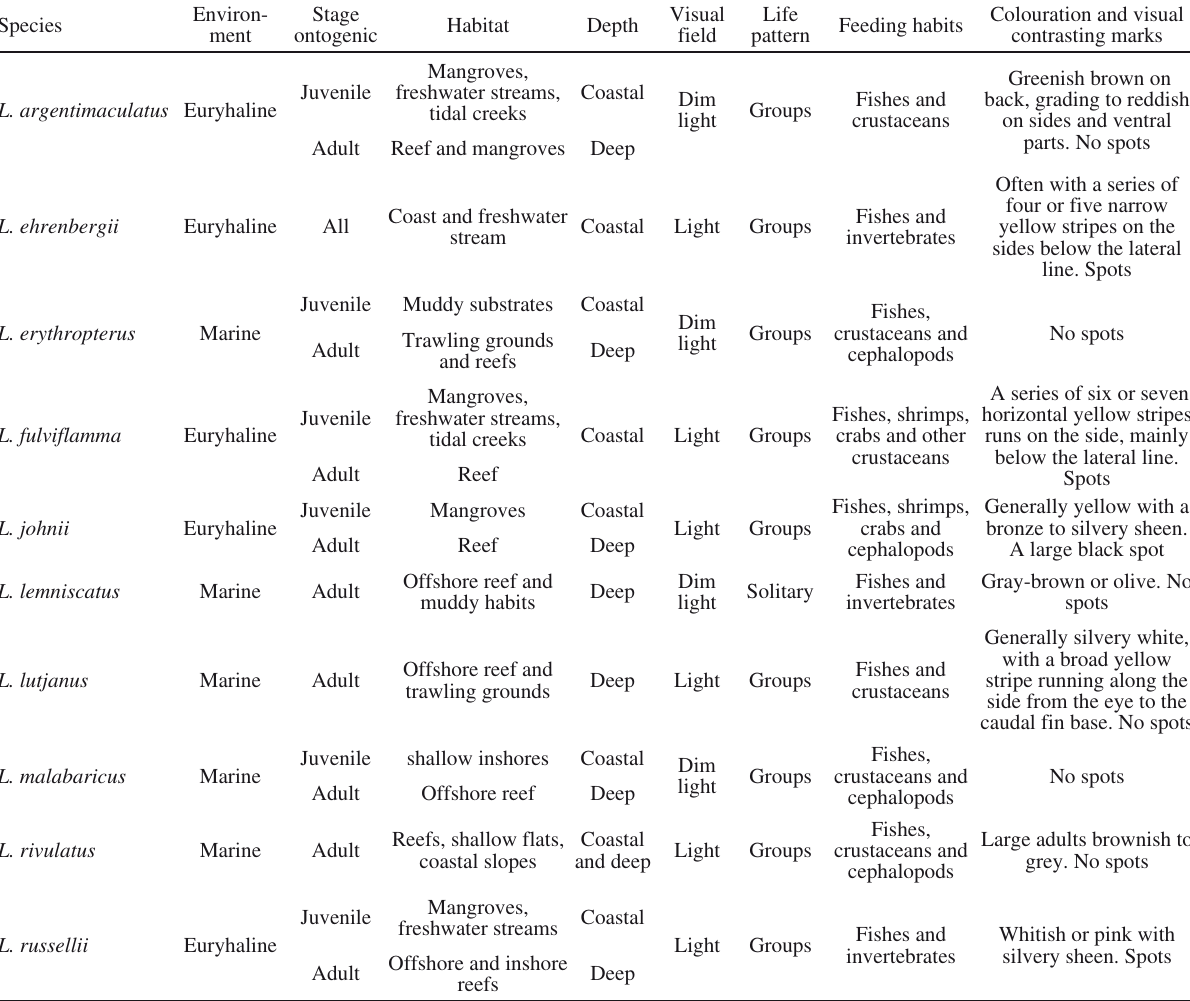
Table 2. − Summary of ecological, functional, morphological and feeding characteristics of snappers in the Persian Gulf according to Allen